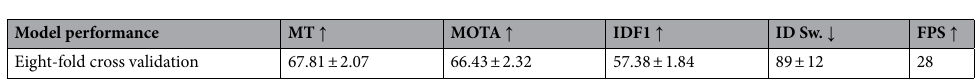
Figure 5. DefectTrack’s standalone detector performance. ( a–f ) Examples of the detector performance visualized in selected in-situ TEM video frames with color-coded confusion box-map comparison: true positive (turquoise), false positive (red), and false negative (yellow). Detection is presented here at video frames with a time interval of 1941.7 ms. Turquoise arrows indicate defect clusters with high detection confidence. Yellow arrows mark representative defect clusters with considerably weak contrast and are occasionally missed by the detector. Red arrows mark the misidentified defect clusters.